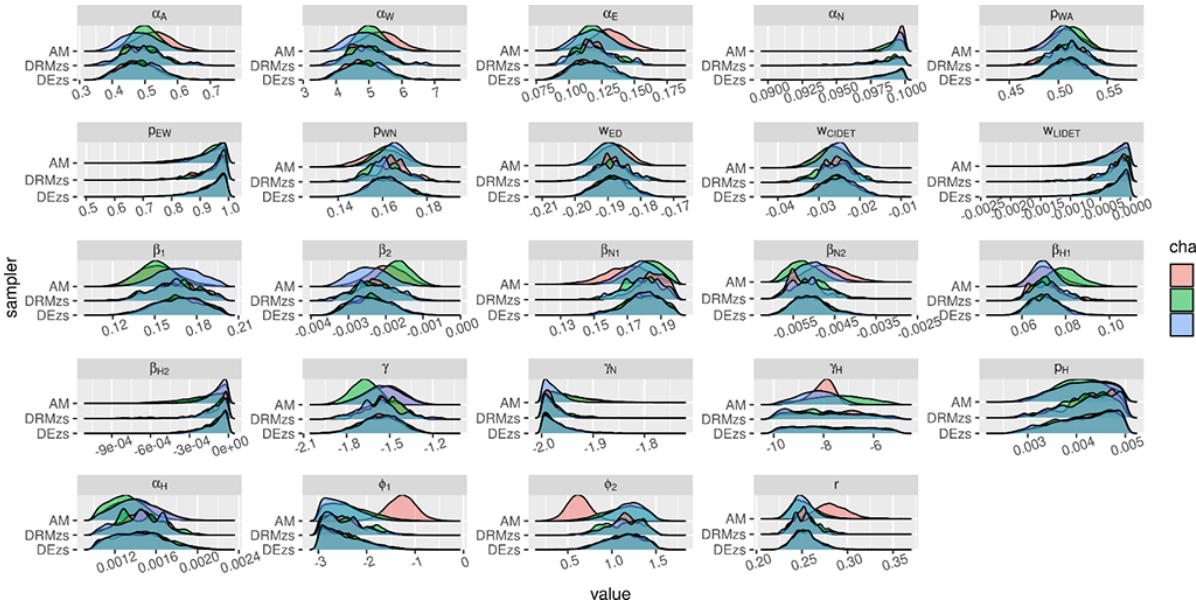
Figure 1. The global calibration results with the different calibration methods.